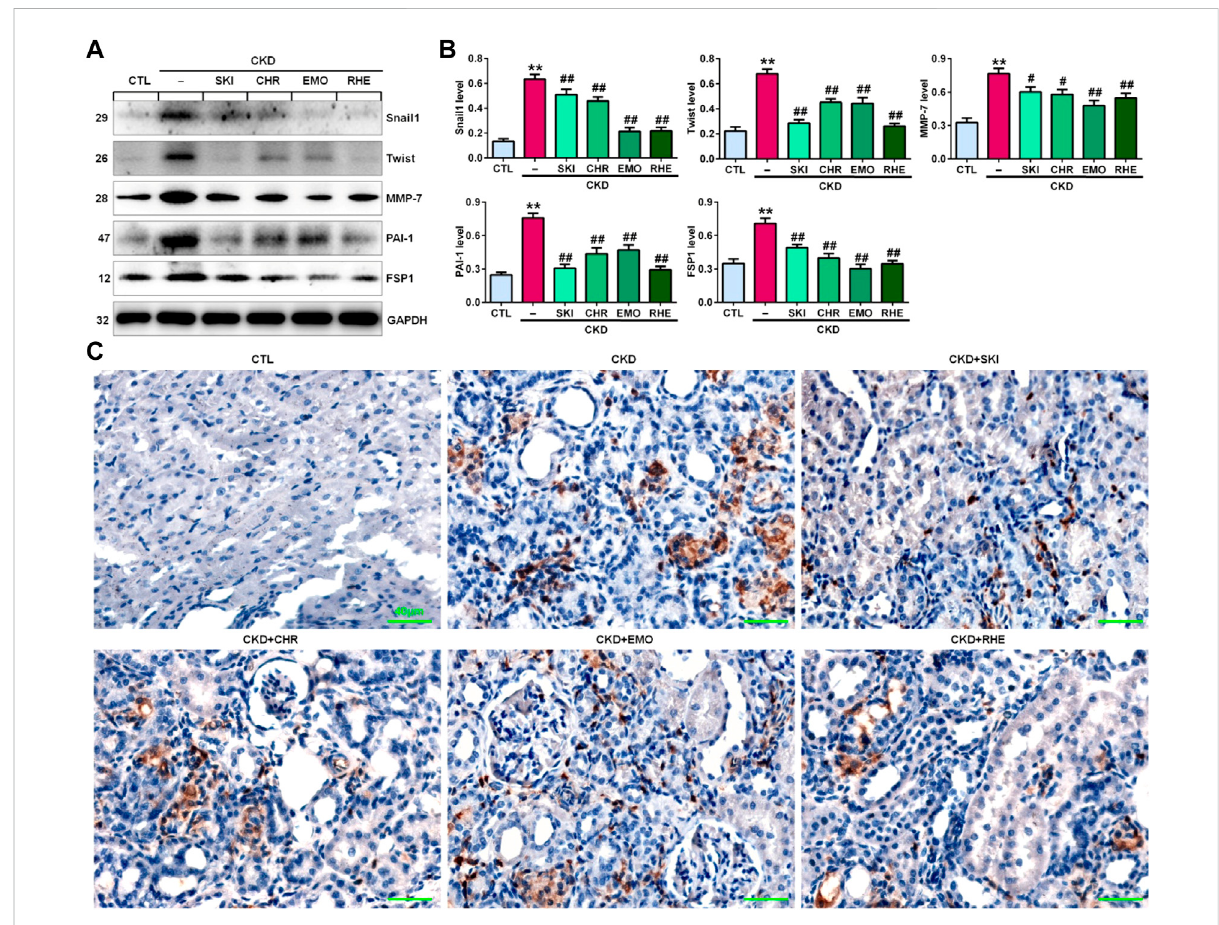
FIGURE 3 SKI inhibited the downstream target genes of β -catenin in CKD rats. (A) Protein expression levels of intrarenal Snail1, Twist, MMP-7, PAI-1, and FSP1 in the different groups. (B) Quantitative analysis of the protein expression of intrarenal Snail1, Twist, MMP-7, PAI-1, and FSP1 in the